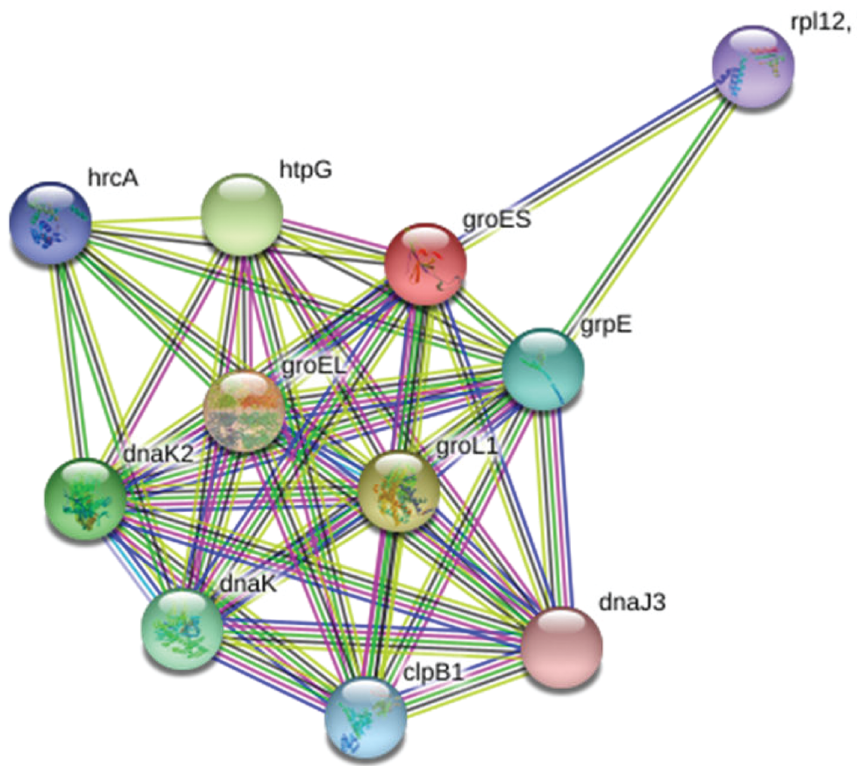
Figure 7: Snapshot showing the STRING database interaction of the query protein with the other proteins of the Prochlorococcus marinus MIT